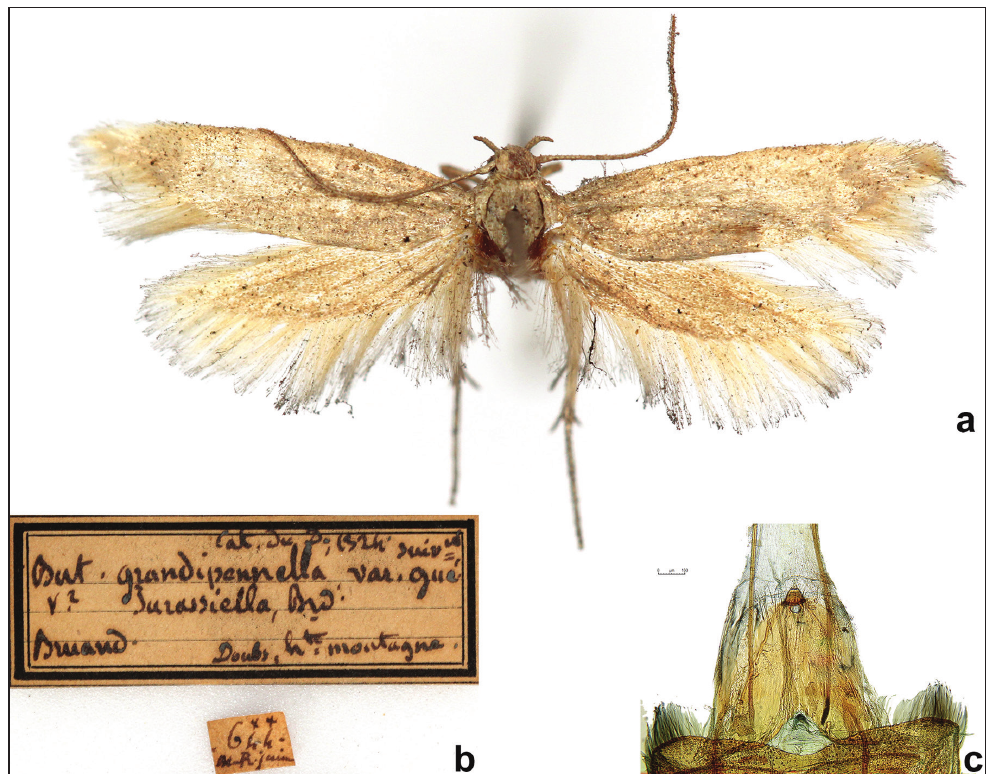
Figure 1. Holotype of Scythris jurassiella (Bruand, 1858), female. a – habitus, wingspan 15 mm; b – original labels; c – genitalia, detail of